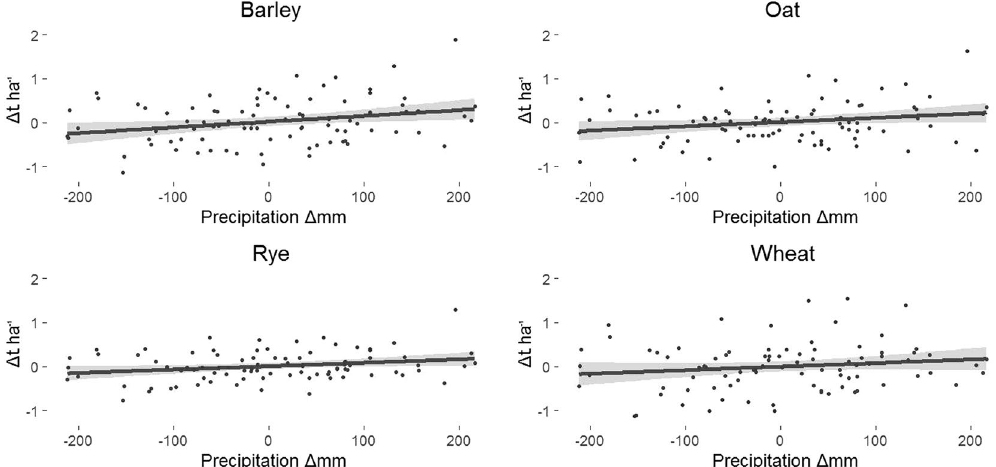
Figure 1. Multiple scatter plot for the linear relationship between the first-differences of March–August precipitation sums and the annual yield means of four crops in the period 1921–2010 29 . Precipitation shows significantly positive, temperature trend-like negative linear relationship with studied crop yields (See: